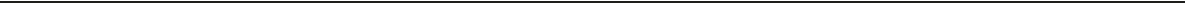
Fig. 2 Klf4 regulates NPC neuronal differentiation and proliferation. a (Upper) Immunostaining with Tuj1 (red) or Map2 (red) antibodies in NPCs infected with pLKO.1-shScramble or pLKO.1-shKlf4 (#1, #2, and #3) lentivirus. DAPI (blue). Scale bars, 50 μ m. (Lower left) NPCs expressing Flag-Klf4 were transfected with pLKO.1-shScramble or pLKO.1-shKlf4 #1, #2, and #3, and one day later, Flag and α -tubulin in lysates were detected by immunoblotting ( n = 2). (Lower right) Quanti fi cation of the proportion of Tuj1 + or MAP2 + cells in the analysis shown above. b (Left) Immunostaining of samples equivalent to those shown in a with Nestin or Ki67 (both red) antibodies. DAPI (blue). Scale bars, 50 μ m. (Right) Quanti fi cation of Ki67 + ( n = 2 or 3) or Nestin + ( n = 3) cells in samples analyzed at left. c qPCR analysis of indicated transcripts in NPCs transfected with pLKO.1-shScramble or pLKO.1-shKlf4 lentiviral vector and grown 2 days in N2 medium without bFGF ( n = 3). d (Left) Klf4 cKO NPCs transfected with Control-EGFP vector or Klf4-EGFP vector. GFP + cells were assessed after 1 or 2 days of culture in N2 medium. (Right) Analysis of neurite length in GFP-positive NPCs on 1 or 2 days of differentiation. e qPCR analysis of indicated transcripts in samples equivalent to those shown in d ( n = 3). f (Upper) Immunostaining with Tuj1 (green) or Map2 (red) antibodies in NPCs infected pCDH-Klf4 or pCDH-control lentivirus. DAPI (blue). Scale bars, 50 μ m. (Lower left) NPCs were infected with pCDH-Flag-Klf4 or pCDH-control lentivirus, and one day later, Flag and α -tubulin in lysates were detected by immunoblotting ( n = 2). (Lower) Quanti fi cation of results shown above. g (Left) Immunostaining with Nestin or Ki67 (both red) antibodies in samples shown in f . DAPI (blue). Scale bars, 50 μ m. (Right) Quanti fi cation of results shown at left. Data are presented as mean ± SD. t test analysis was performed to calculate statistical signi fi cance (* P < 0.05, ** P < 0.005, *** P < 0.0005). See